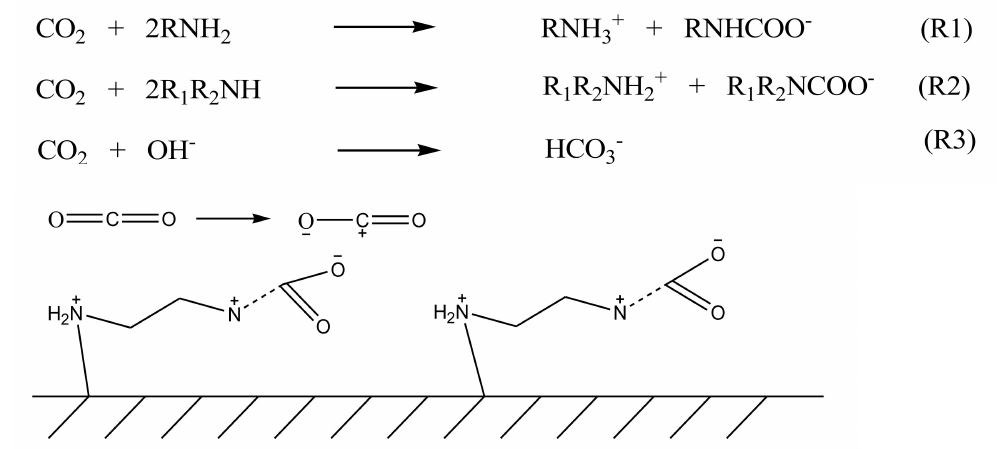
Figure 6. Proposed reaction mechanism between EDA and CO 2 at the surface of amine-functionalized mesoporous carbon.